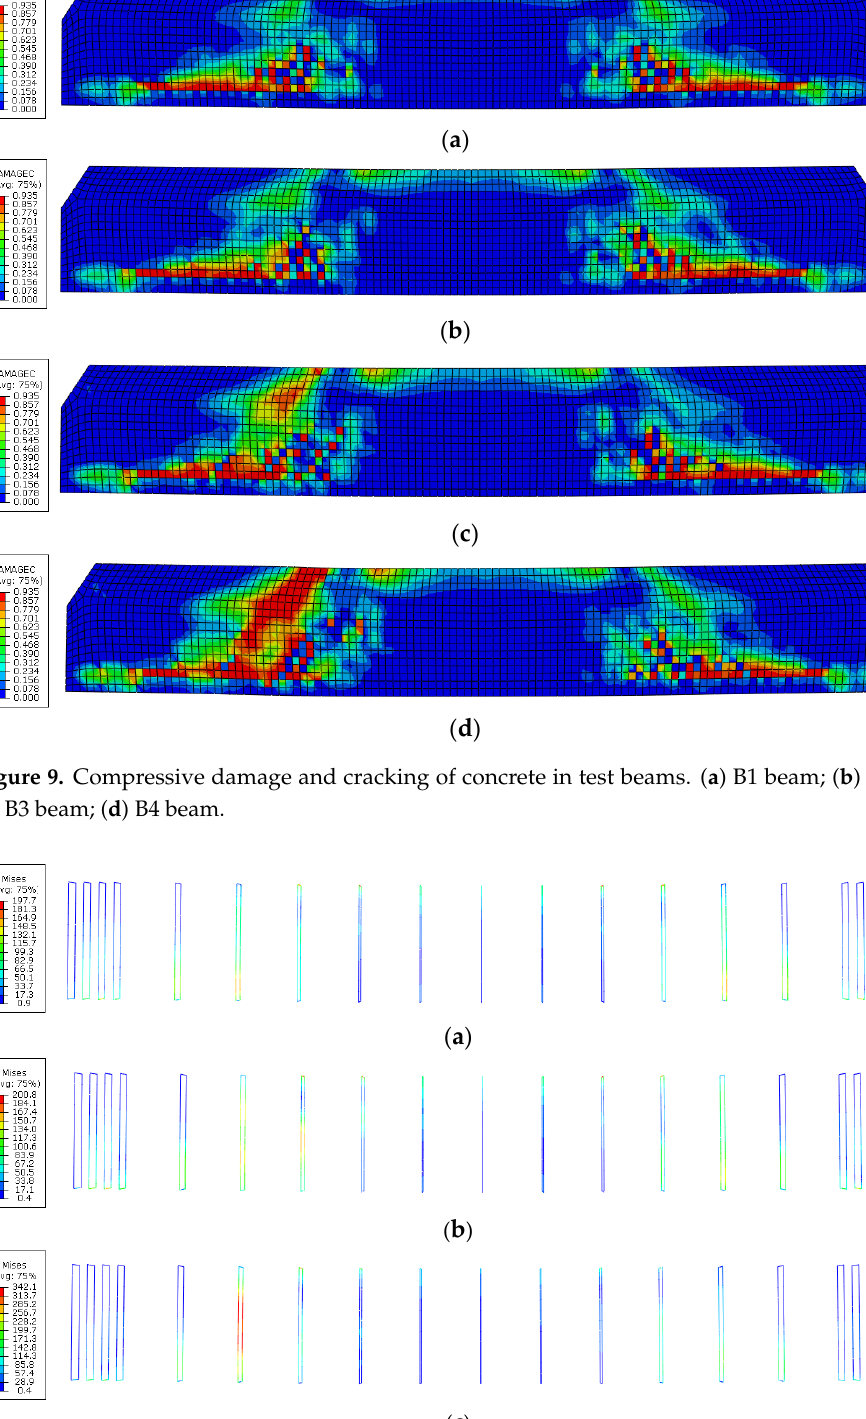
Figure 8. Tensile damage and cracking of concrete in test beams. ( a ) B1 beam; ( b ) B2 beam; ( c ) B3 beam; ( d ) B4 beam.